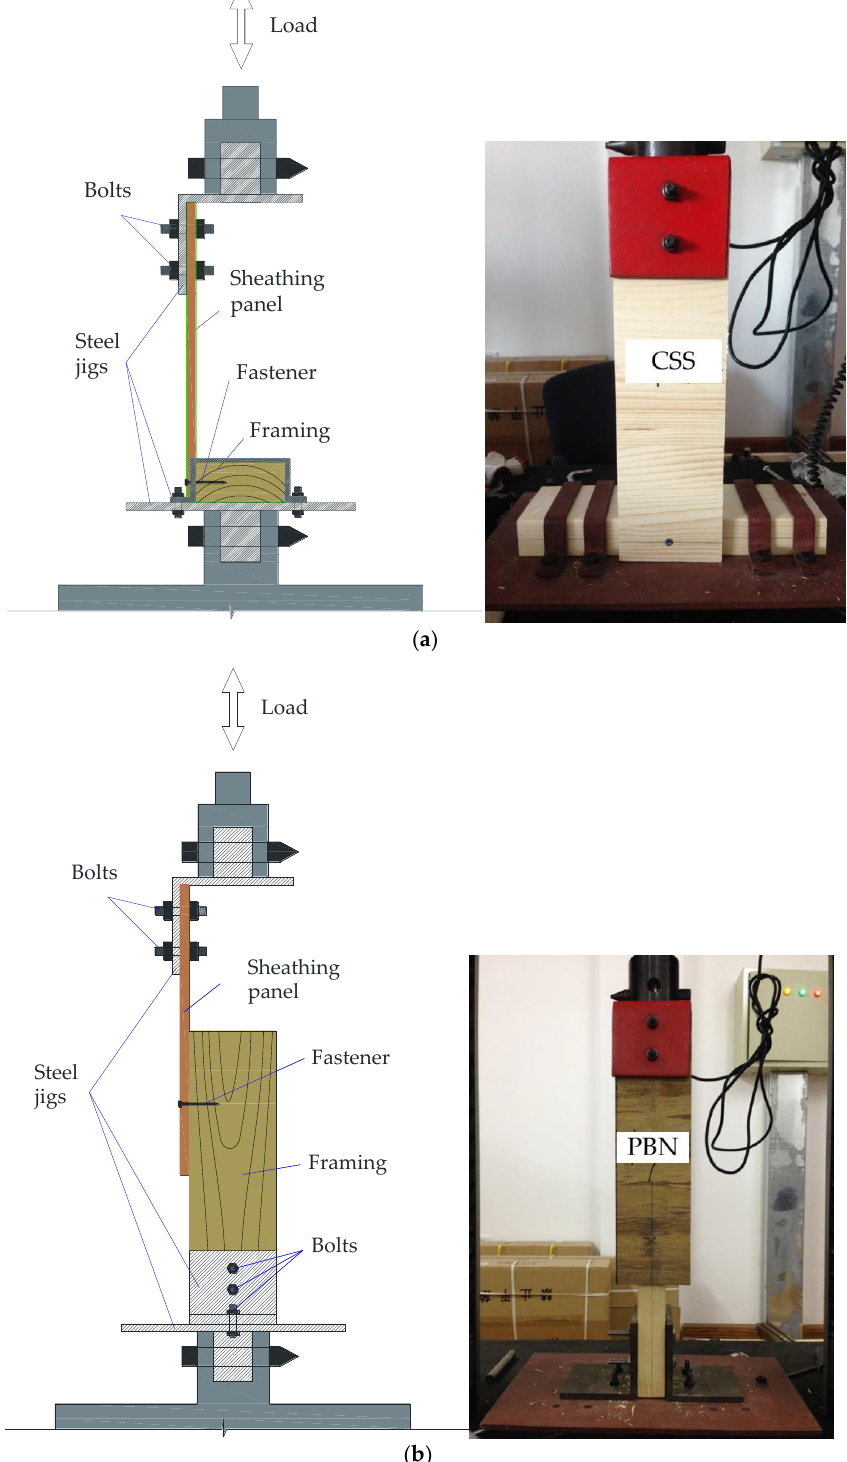
Figure 2. Experimental setups of the joints: ( a ) Perpendicular joints; ( b ) Parallel joints.